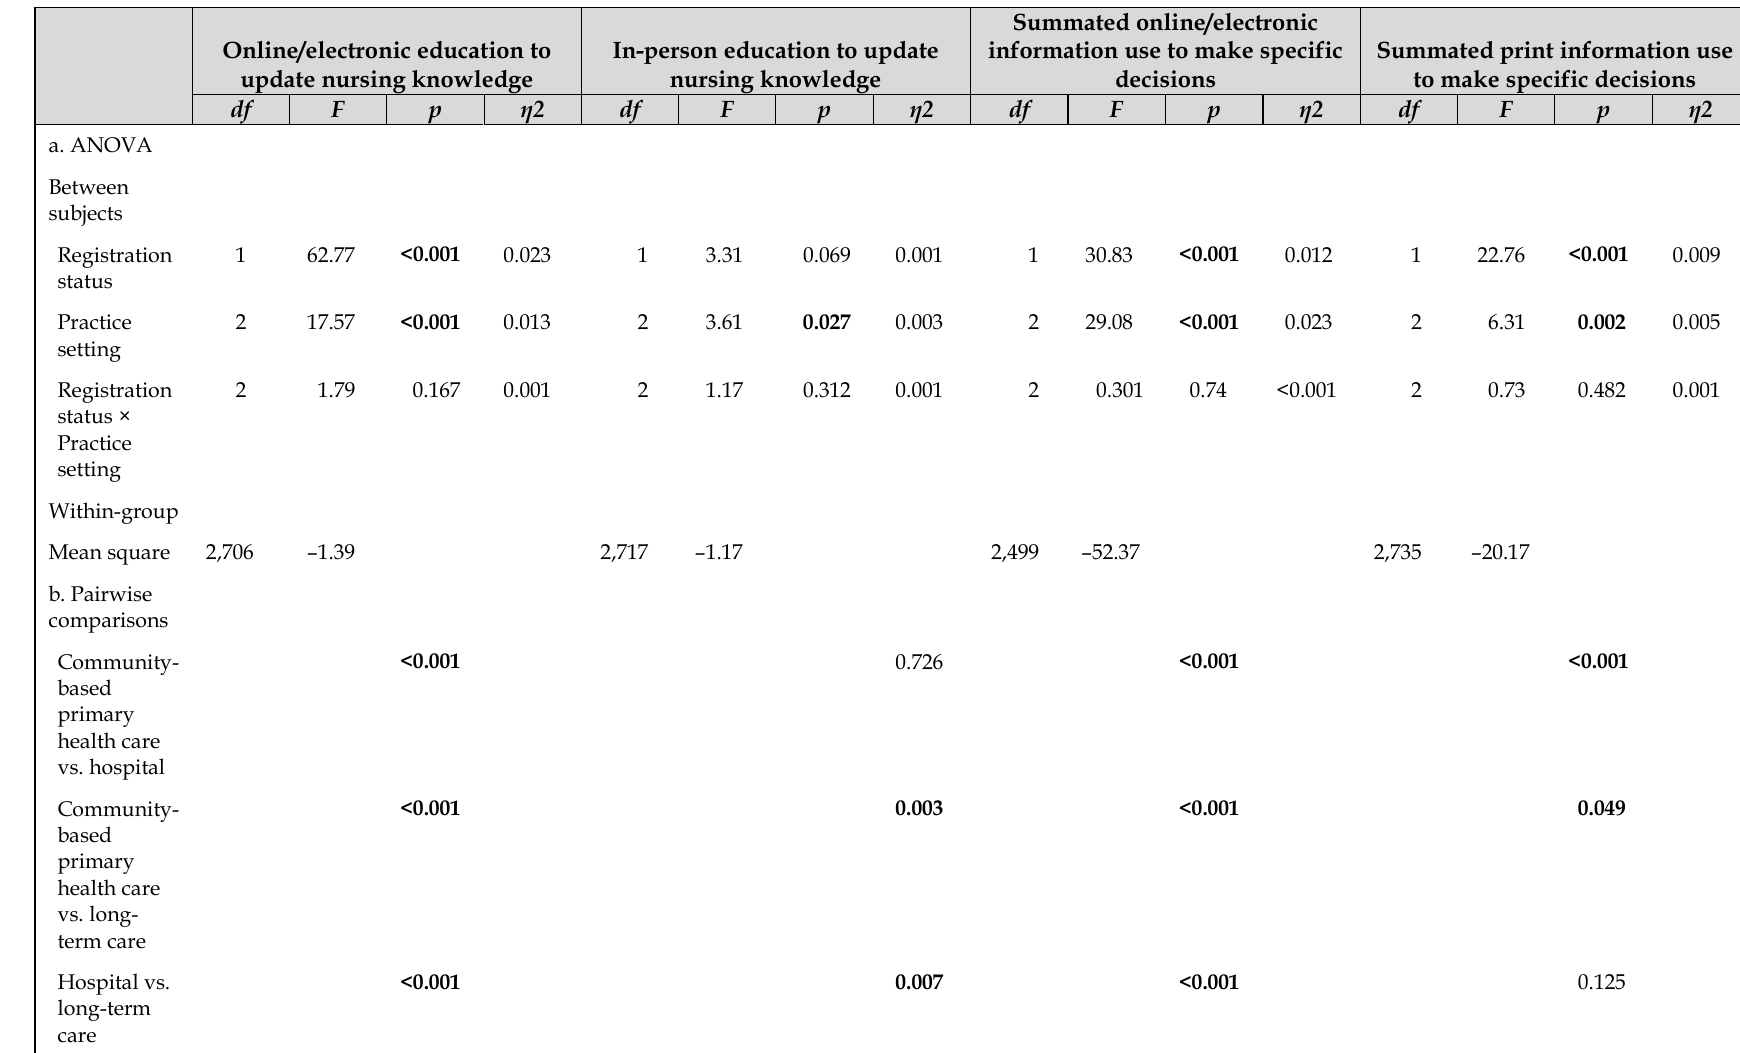
Table 5 Use of education and information, two-way analysis of variance (ANOVA) results for registration status and practice setting main effects